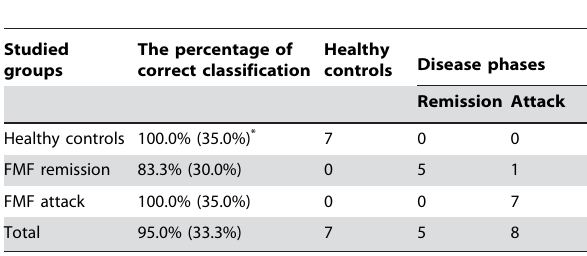
* apriori probability of correct classification.